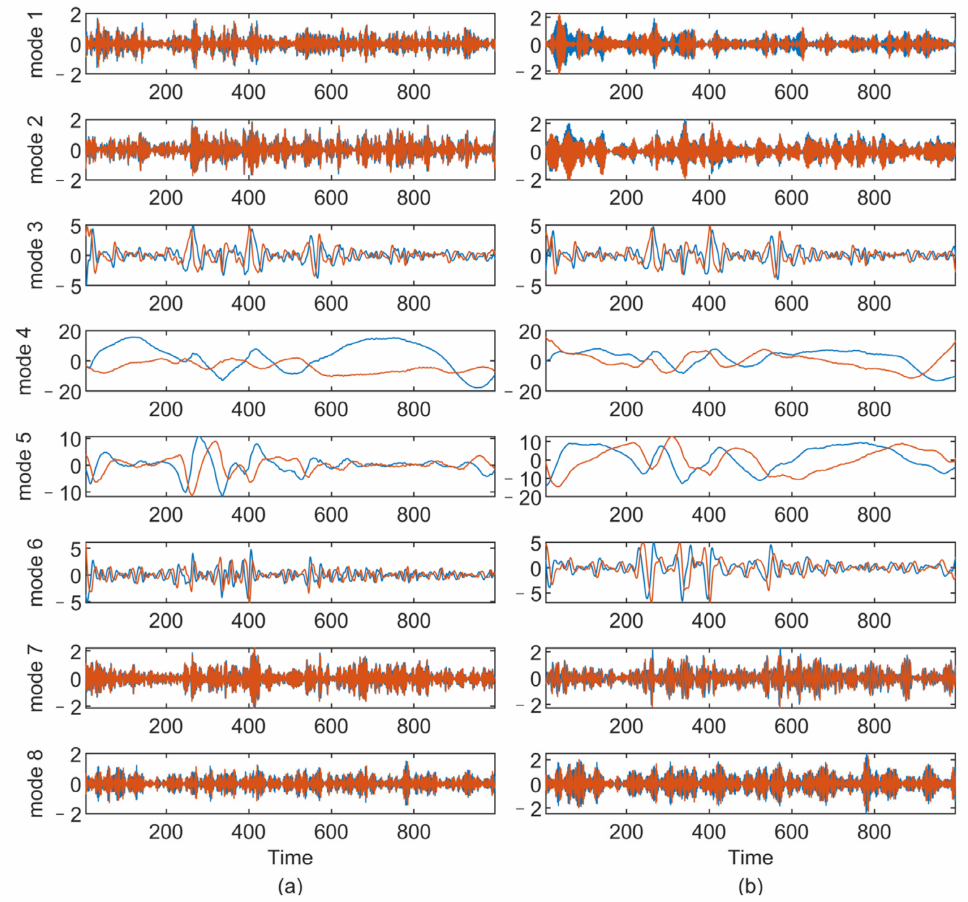
Figure 13. The decomposition results of the complex-valued wind data: ( a ) MCVMD results and ( b ) CVMD